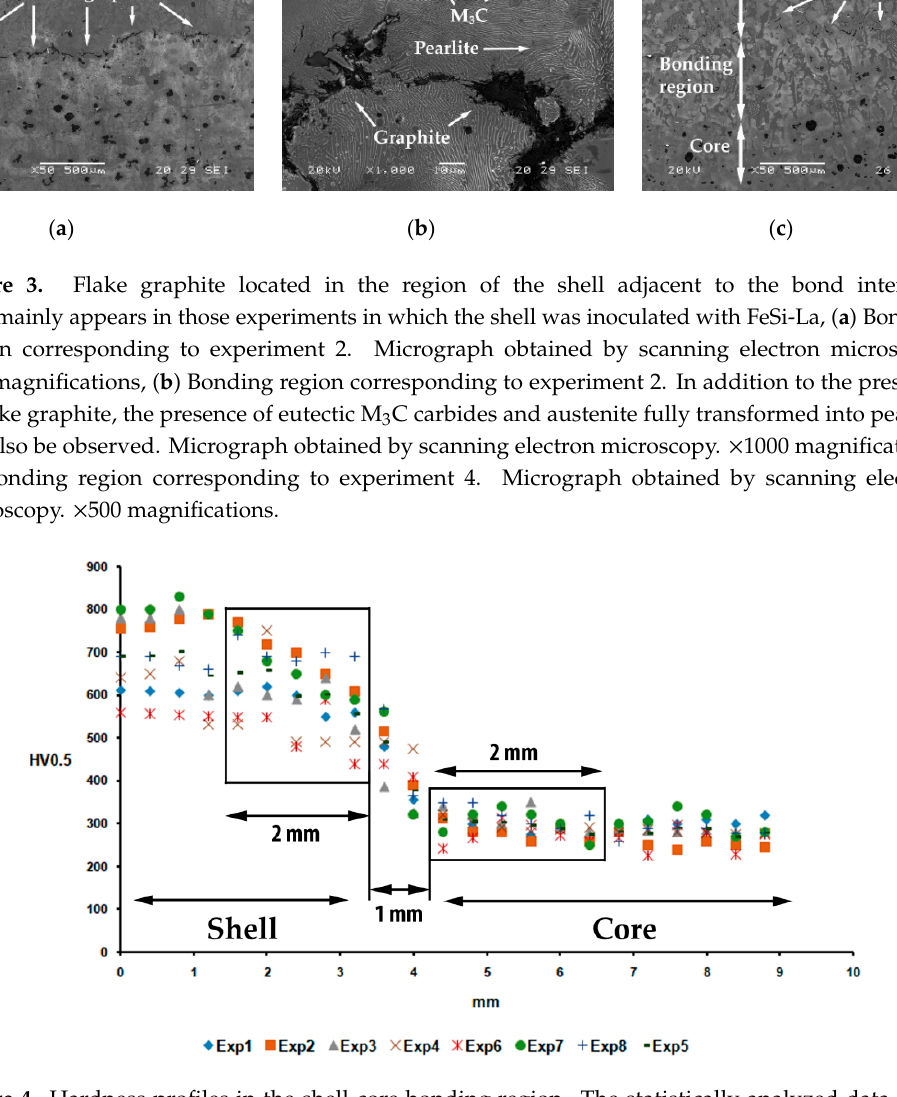
Figure 4. Hardness profiles in the shell-core bonding region. The statistically analyzed data were collected from a width of 2 mm in the regions of the shell and the core adjacent to the bond interface between both. Exp (Experiment).